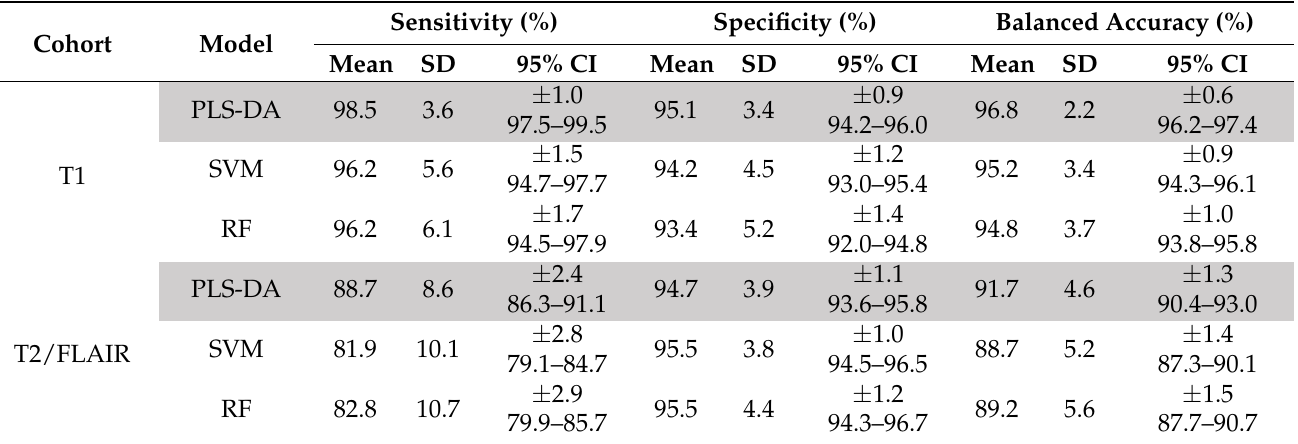
Table 1. Summary of sensitivity, specificity and balanced accuracies with each classification for both T1 and T2/FLAIR tumour volumes versus controls. Partial least squares-discriminant analysis (PLS-DA), support vector machine (SVM) and random forest (RF). Top performing model is highlighted in